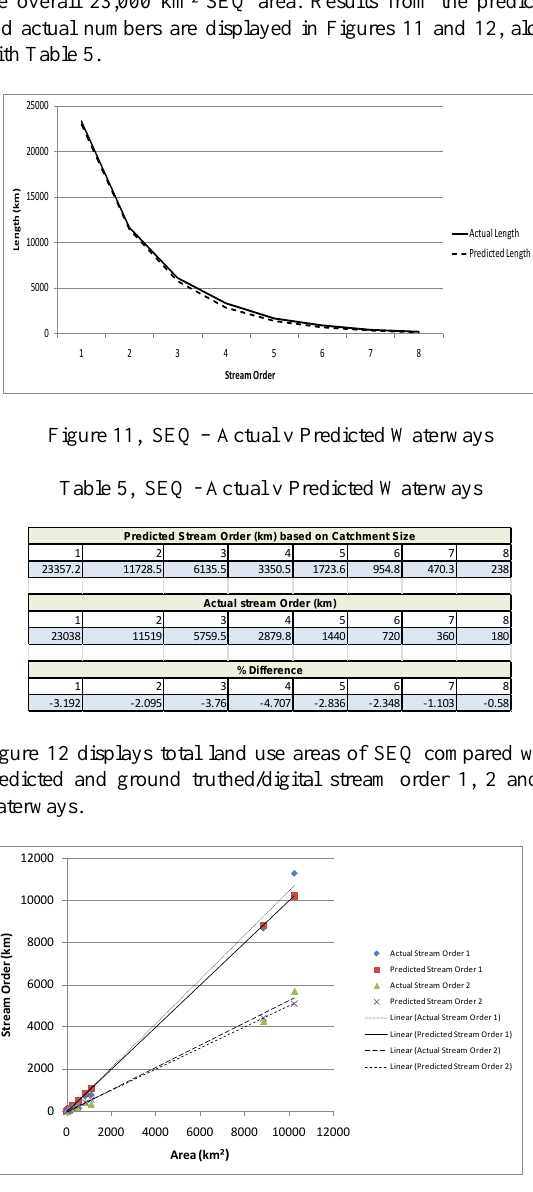
Figure 12, SEQ – Land Area v Actual Stream Order 1 and 2 Waterways, Predicted Stream Order 1 and 2